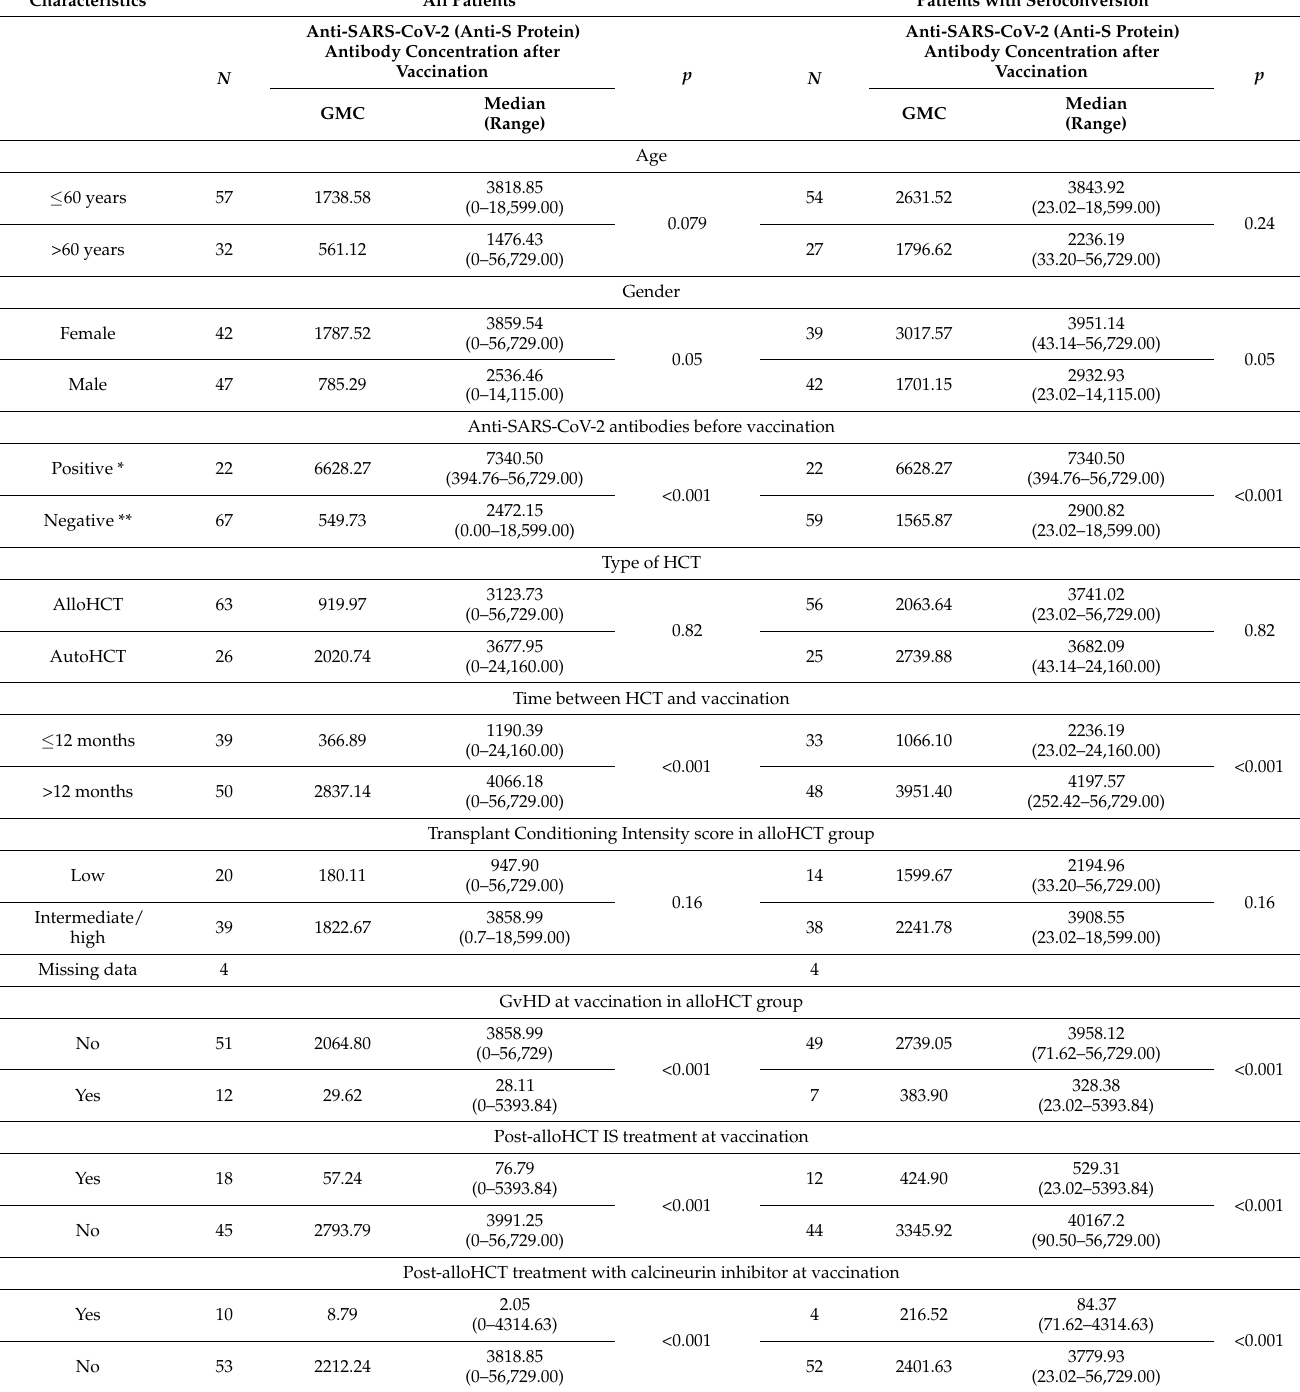
Table 3. Humoral response after SARS-CoV-2 vaccination by baseline patients’